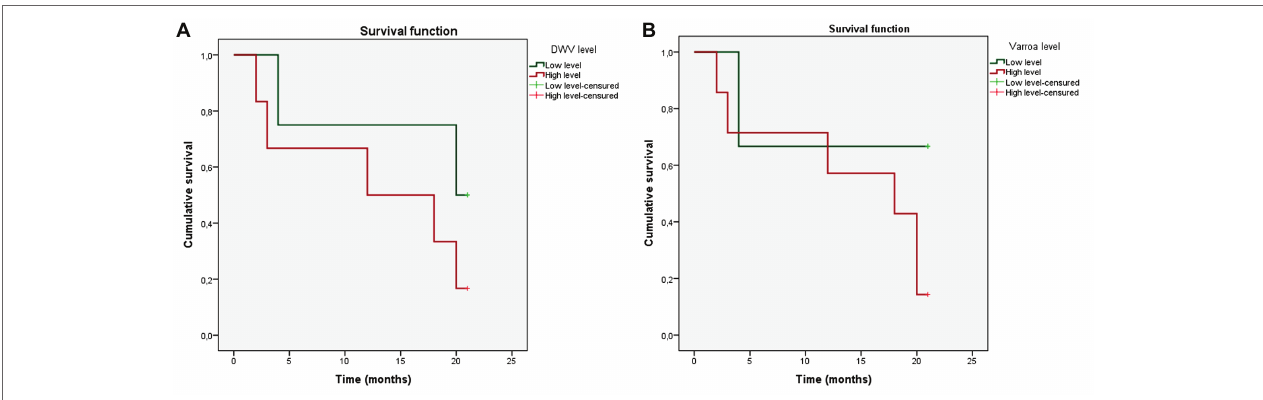
FIGURE 3 | Overall survival according to different DWV (A) and Varroa destructor (B) levels. Green color represents low levels of pathogen; red color represents high levels of